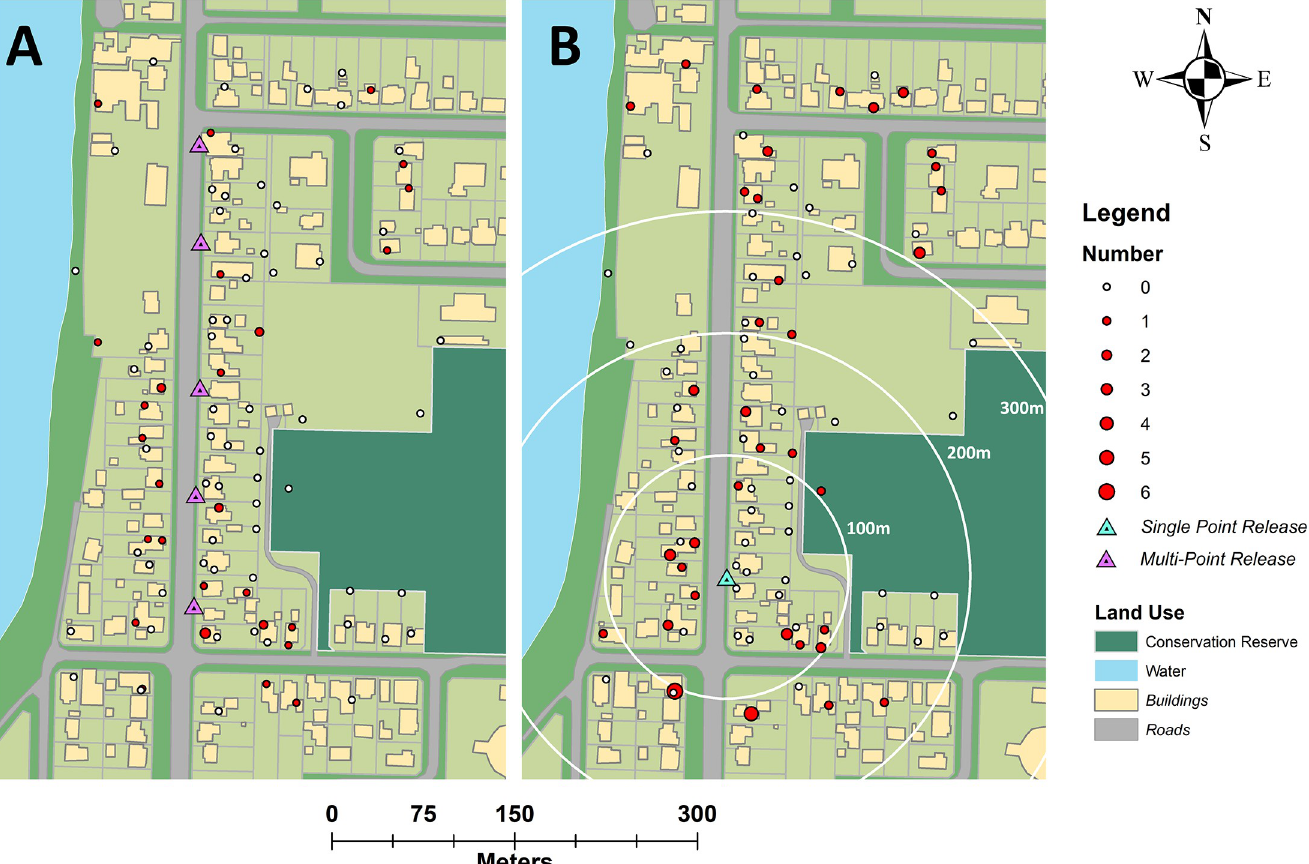
Fig 5. Total rhodamine B inseminated Aedes aegypti females captured during multi-point (5A) and single point releases (5B). Size and colour of circles indicates the total females caught in an individual trap (see key). Release points for each release type are indicated by blue triangle (single point) and purple triangles (multi- point). Landuse basemap digitized manually [38].